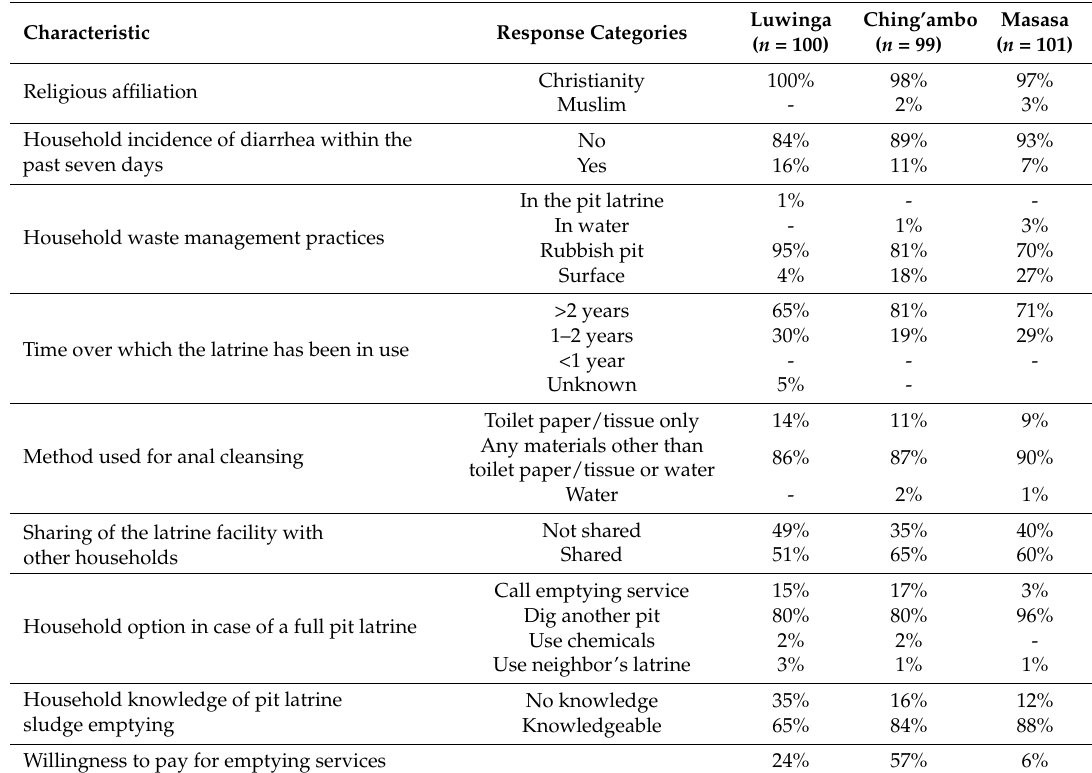
Table 1. Household sanitation practices and knowledge of pit latrine emptying ( n =